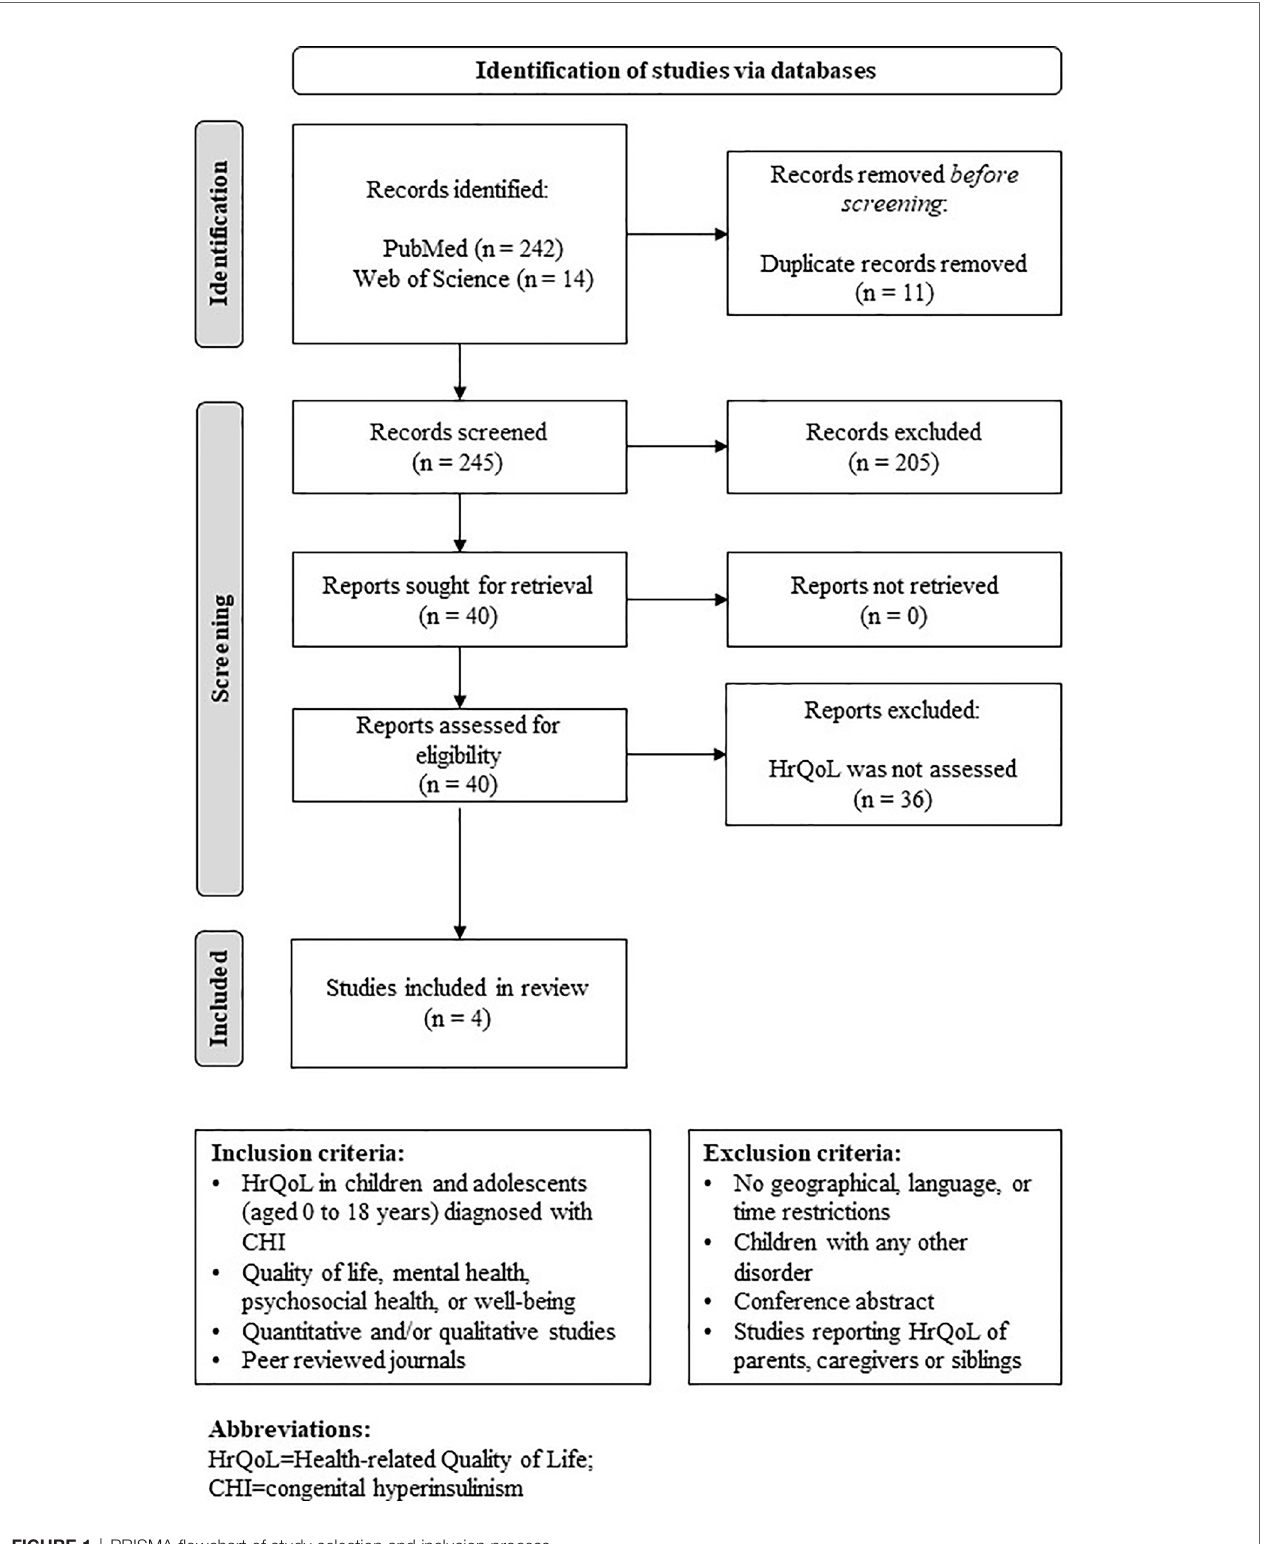
FIGURE 1 | PRISMA fl owchart of study selection and inclusion